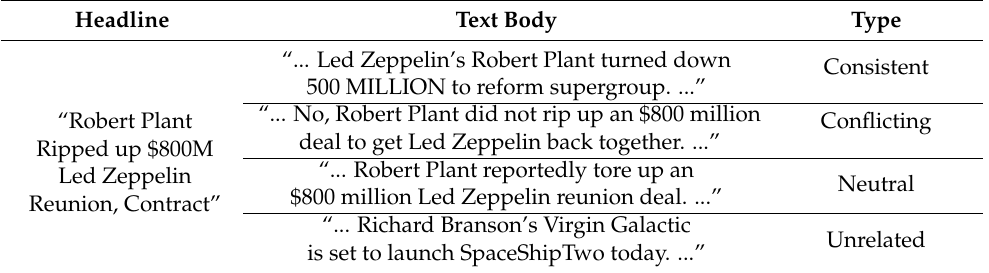
Table 2. Case study.